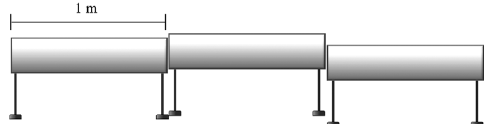
FIG. 2. Model 1: Horizontal guide pieces of 1 m length, shifted in parallel with respect to one another in the fashion devised by Zendler et al. [19].